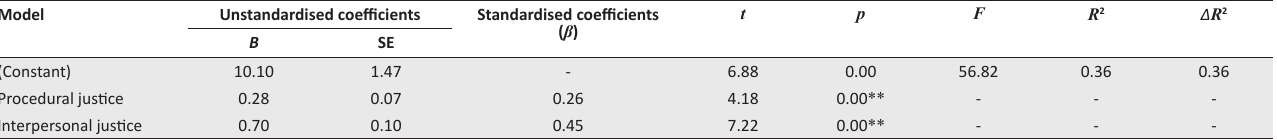
Interpersonal justice